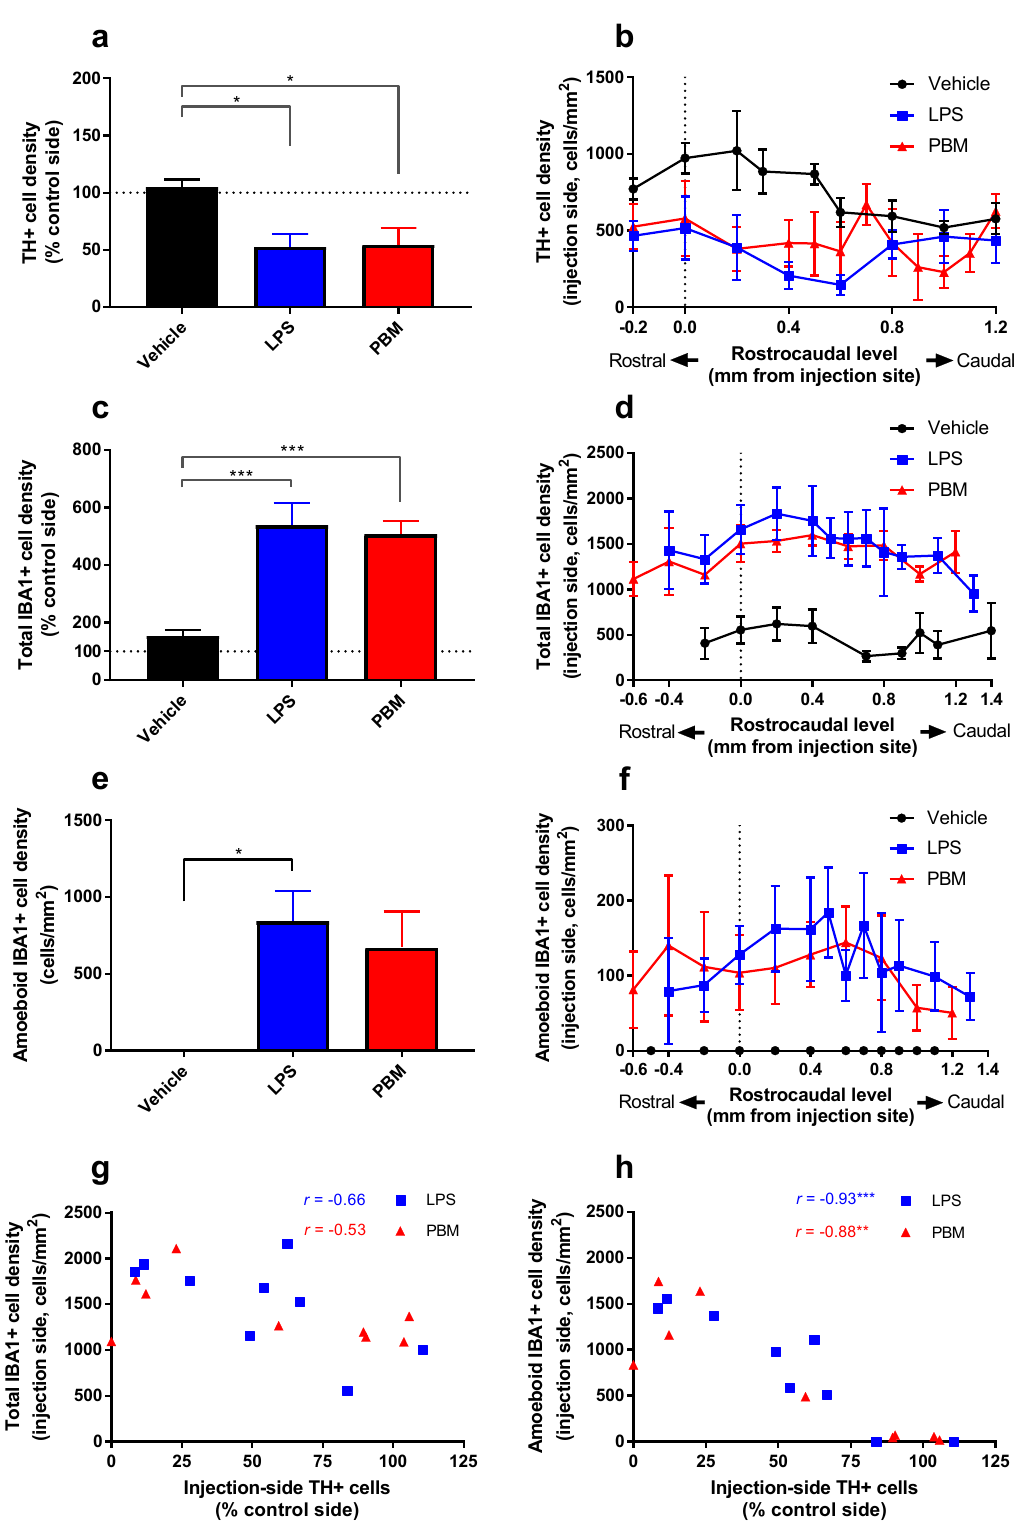
Figure 3. The effects of 20 µg LPS and PBM treatment on TH+ and IBA1+ cell density in the SNc. ( a ) The density (cells/mm 2 ) of TH+ cells in the left (injection side) SNc expressed as a percentage of the contralateral (control) side showed a significant difference between LPS and vehicle rats (* p < 0.05) and between PBM and vehicle rats (* p < 0.05). Both groups had a mean cell loss of ~50%. ( b ) A plot of TH+ cell density in the LPS injection-side SNc, separated by rostrocaudal level and normalised for the level of the injection site in each rat. TH+ cell loss is maximal within ~0.5 mm of the injection site.